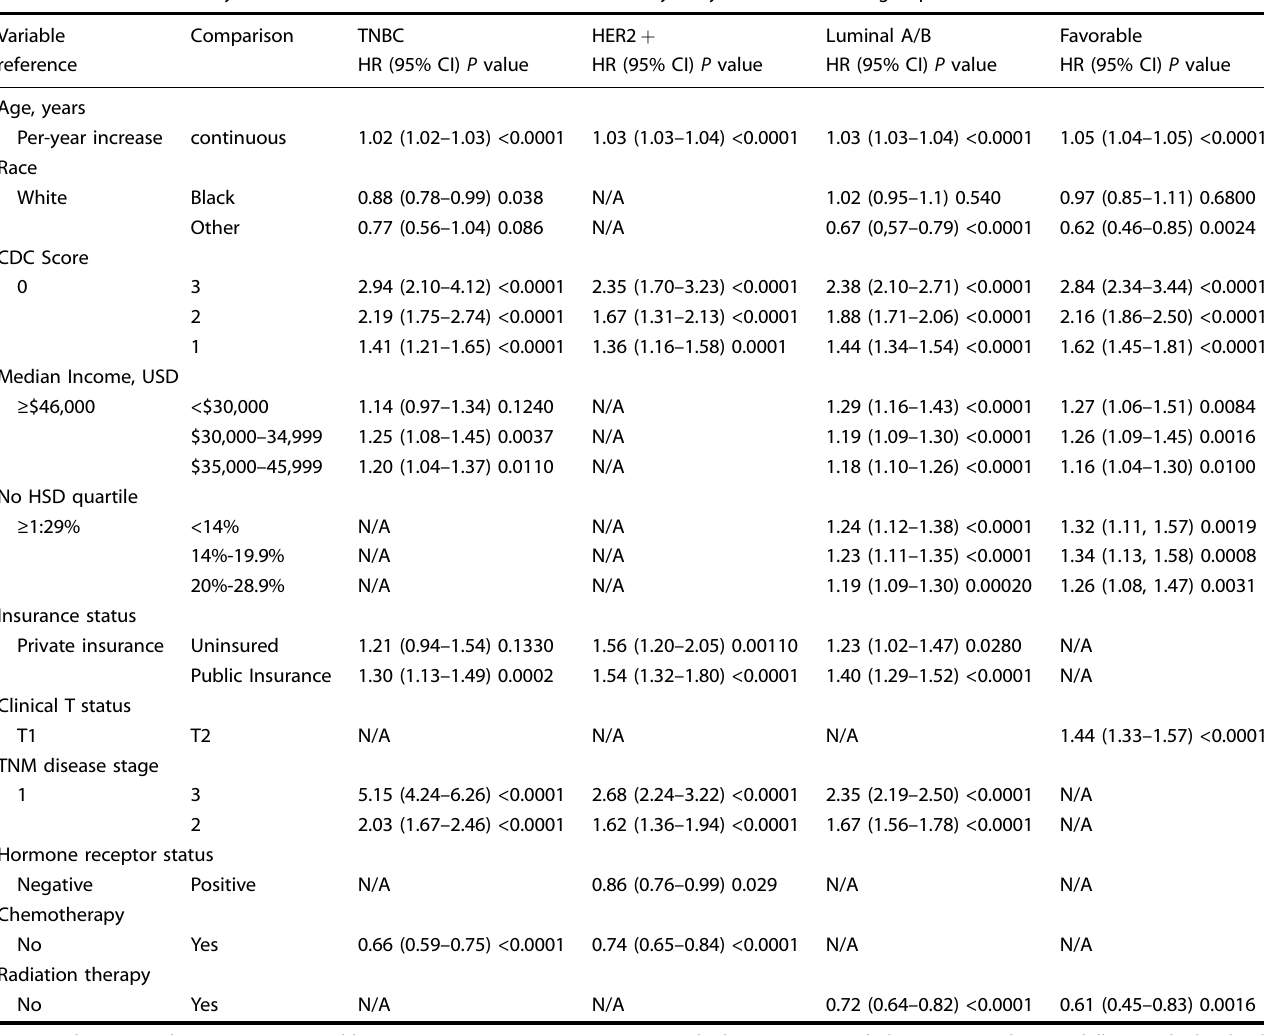
Table 3. Multivariate analysis of factors associated with overall survival analysis by breast cancer